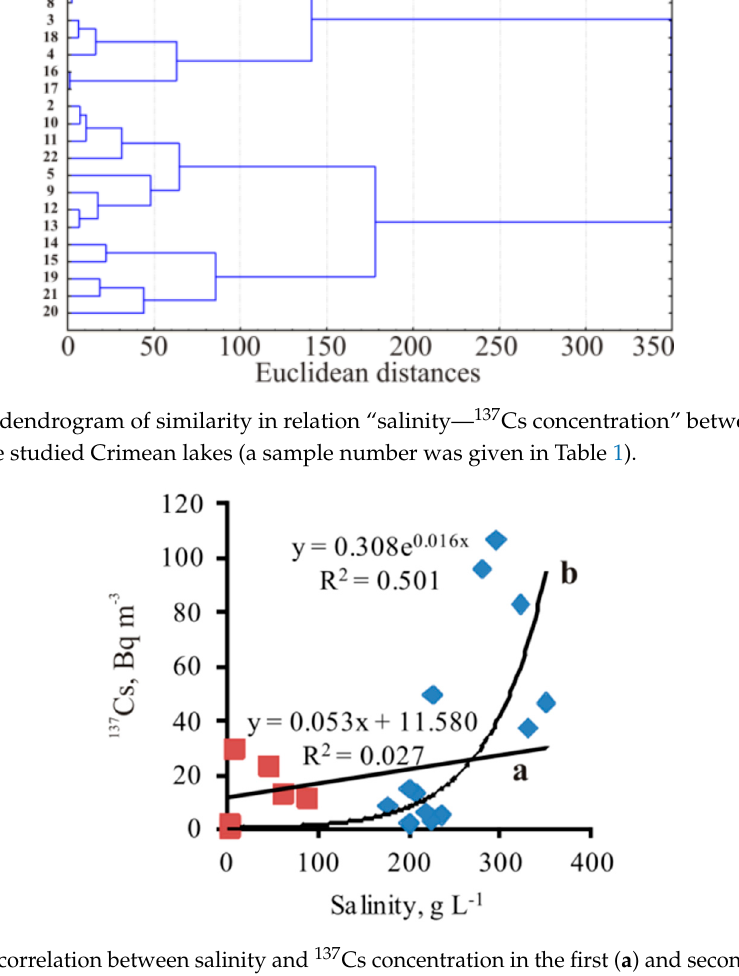
Figure 6. The correlation between salinity and 137 Cs concentration in the first ( a ) and second ( b ) of the studied cluster of the studied lakes.